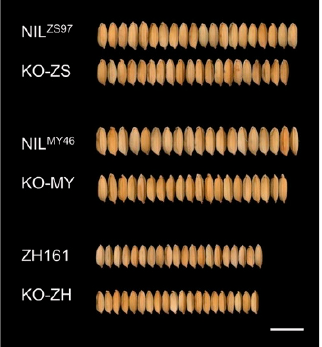
Figure 2. Grains of the recipients and knockout mutants. Bar = 10 mm. A total of twelve independent T 0 mutants were obtained, including three homozygous and nine biallelic mutants (Figure 1B). For NIL ZS97 , two homozygous mutants and one transgenic-negative control were identified. KO-ZS-1 had a 1 bp deletion and KO-ZS-2 had a 1 bp insertion. For NIL MY46 , one homozygous and six biallelic mutants were identified. No negative transformant was found. The homozygous mutant had a 1 bp insertion, and each of the biallelic mutants contained a 1 bp insertion and a 1 bp deletion. For ZH161, three biallelic mutants and one negative transformant were identified. KO-ZH-1 contained a 1 bp insertion and a 1 bp deletion, KO-ZH-2 contained a 1 bp insertion and a 22 bp deletion, and KO-ZH-3 had 22 bp and 35 bp deletions. The mutations all led to a frameshift and produced premature stops before the U-box motif and ARM repeats (Figure